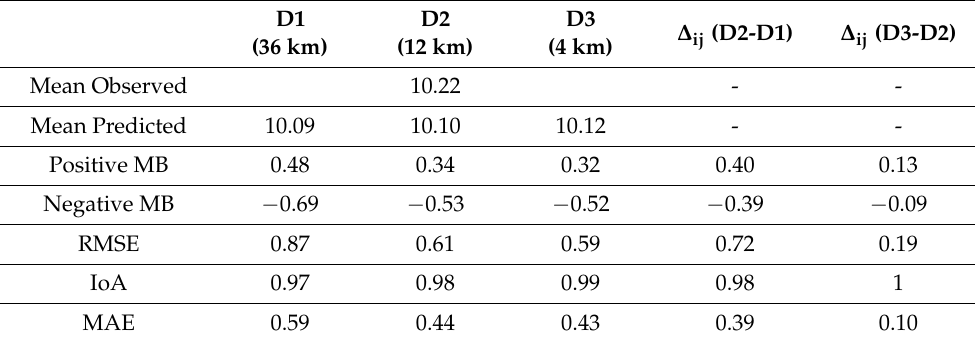
Table 3. Annual mean temperature statistical analysis ( ◦ C).